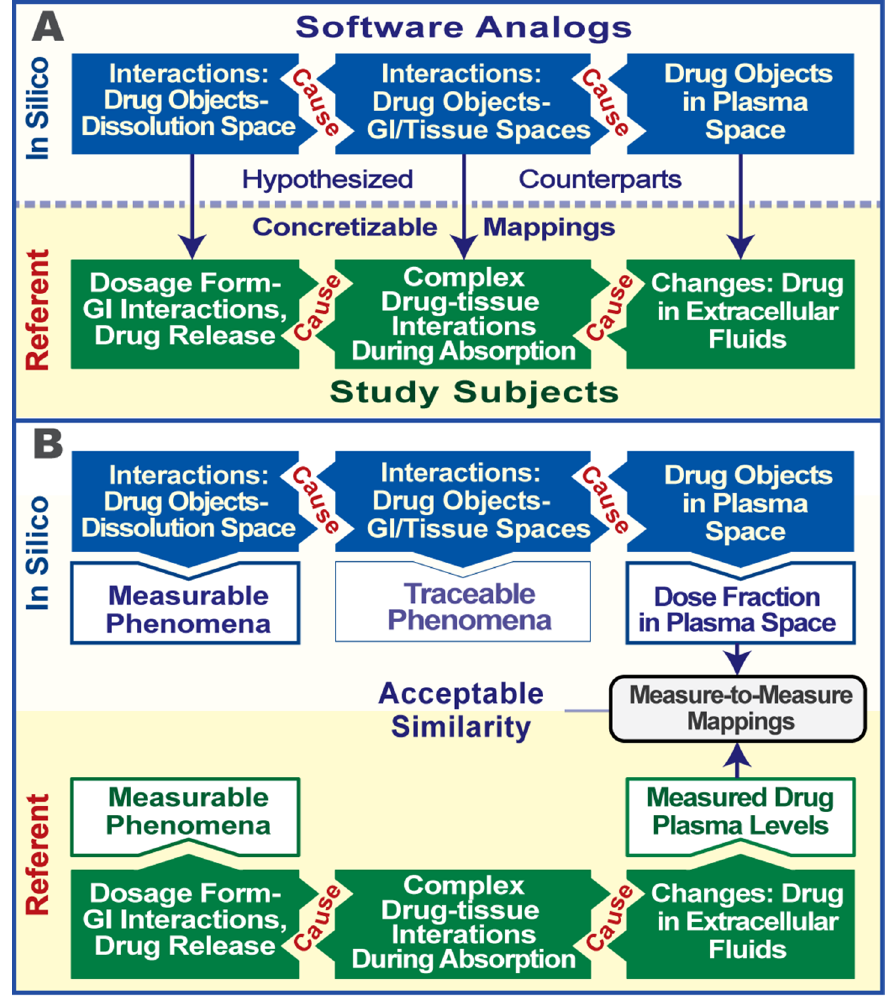
Figure 6. Analog–subject mappings. The engineering objective is to have biomimetic software mechanisms (blue) in which we are building confidence that events occurring during simulations, at different granularities, mimic corresponding events at comparable granularities hypothesized to occur in subjects (green) following dosing. A. Generative mechanisms, phenomena, and their causes occurring during simulations stand as hypotheses (currently quite abstract–coarse grain) about counterparts occurring within each subject. Because all analog events are concrete, those hypotheses are also concretizable mappings. B. The immediate goal is to achieve acceptable, quantitative similarity criteria (measure-to-measure mappings) between each subject’s felodipine plasma profile features and its analog’s counterpart. As similarity criteria are achieved, our confidence increases that simulation details may be predictive. Importantly, influential events within each space can be traced during execution and so can be falsified (or not) by future wet-lab or clinical